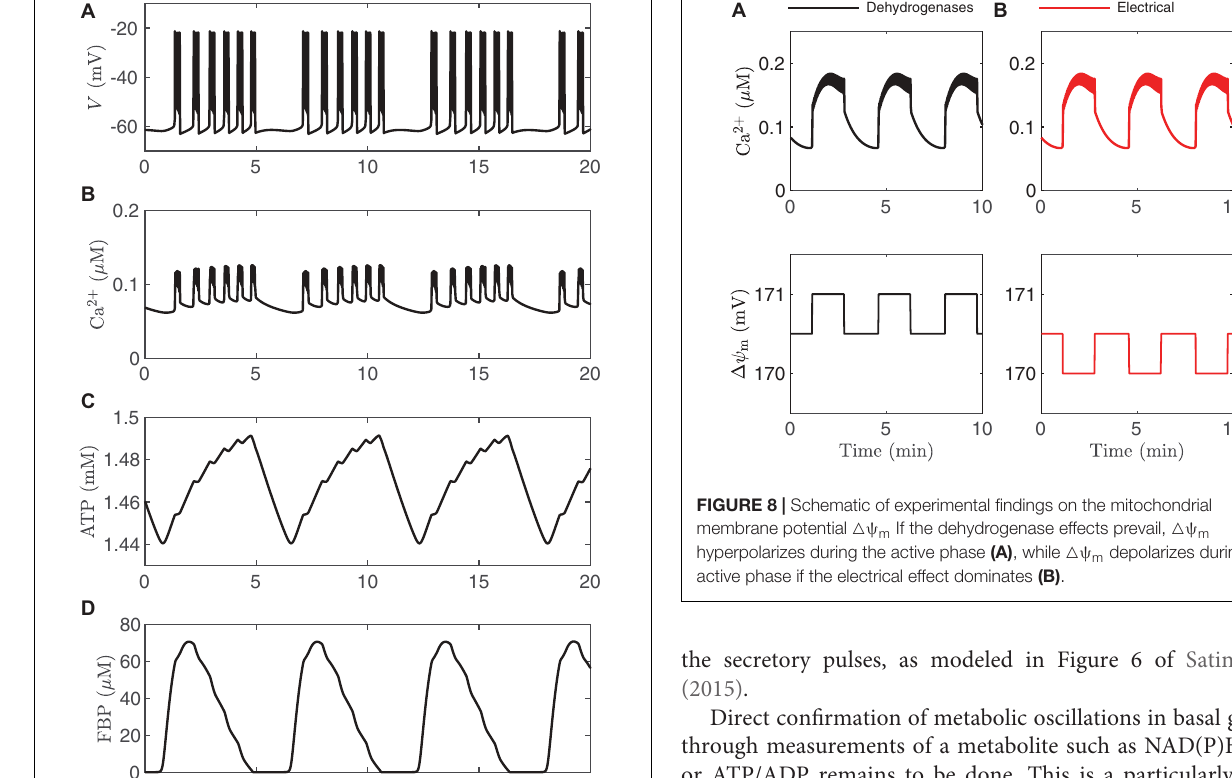
the secretory pulses, as modeled in Figure 6 of Satin et al.